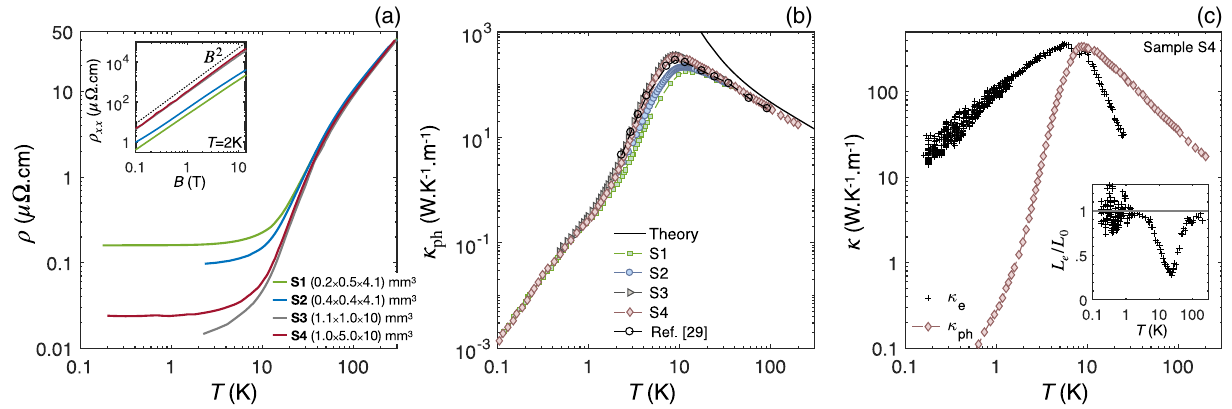
FIG. 1. Electrical and thermal conductivity in Sb crystals along the bisectrix crystallographic orientation. (a) Temperature dependence of the electrical resistivity ρ of four different Sb crystals with different sizes, as indicated in the legend. Residual resistivity is lowest in the largest samples. The inset shows the magnetoresistance of these crystals at T ¼ 2 K. (b) Lattice thermal conductivity κ four Sb samples. Data from a previous report on a Sb rod [29] are also included. Note the absence of size dependence at low temperatures. The solid line represents theoretical lattice thermal conductivity considering only three-phonon scattering events (and neglecting scattering by electrons). Note that, at high temperature, theory tracks the experimental data but not at low temperature. We attribute this to significant scattering of phonons by electrons. (c) Temperature dependence of the electronic and phononic contributions to the total thermal conductivity in sample S4. The procedure for separation is discussed in detail in Supplemental Material [22]. The inset shows the temperature dependence of the electronic Lorenz number L e ¼ κ e ρ =T normalized by L 0 , the Sommerfeld